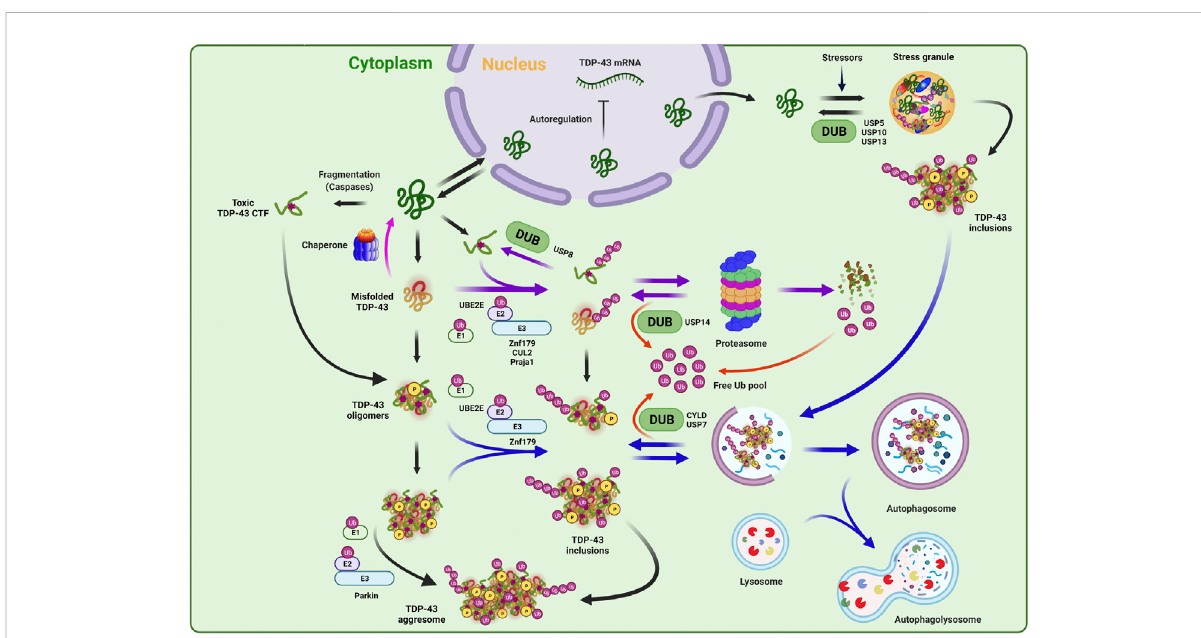
FIGURE 2 Ubiquitination and deubiquitination mechanisms in TDP-43 regulation. TDP-43 protein level can be tight regulated by multi-dimensional proteostasis surveillance systems. In the normal conditions, the TDP-43 amount in the cell is maintained via a negative feedback loop mechanism in which TDP-43 autoregulates and suppresses its own mRNA expression. Under the pathological conditions, TDP-43 translocates from nucleus to cytoplasmtobeaccumulated,andcanbeturnedintovariouspathologicalspecies,suchasmisfolded,oligomeric,ortruncatedtoxicC-terminal TDP-43 fragment. Under the prolonged stress conditions, TDP-43 also can be recruited into aberrant stress granules, forming toxic aggregates or insolubleinclusions.TDP-43canberefoldedbychaperonesorrecognizedandeliminatedbyubiquitin-proteasomesystemandautophagypathway. E2 (UBE2E) and E3 (Parkin, Znf179, CUL2, and Praja 1) enzymes, which have been reported to regulate the quality control or fate decision of TDP-43, are indicated. Note that depending on the ubiquitination events by given enzymes, the ubiquitin conjugates are doomed to be degraded by proteasome or autophagy, or rather to form the pathological aggregates or inclusions. This ubiquitination process can be reversed by deubiquitinating enzymes (DUBs) (USP8, USP14, USP7, and CYLD), thereby regulating TDP-43 stability, editing ubiquitin architecture, and maintaining free ubiquitin pool. DUBs that are involved in stress granule dynamics (USP5, USP10, and USP13) were also